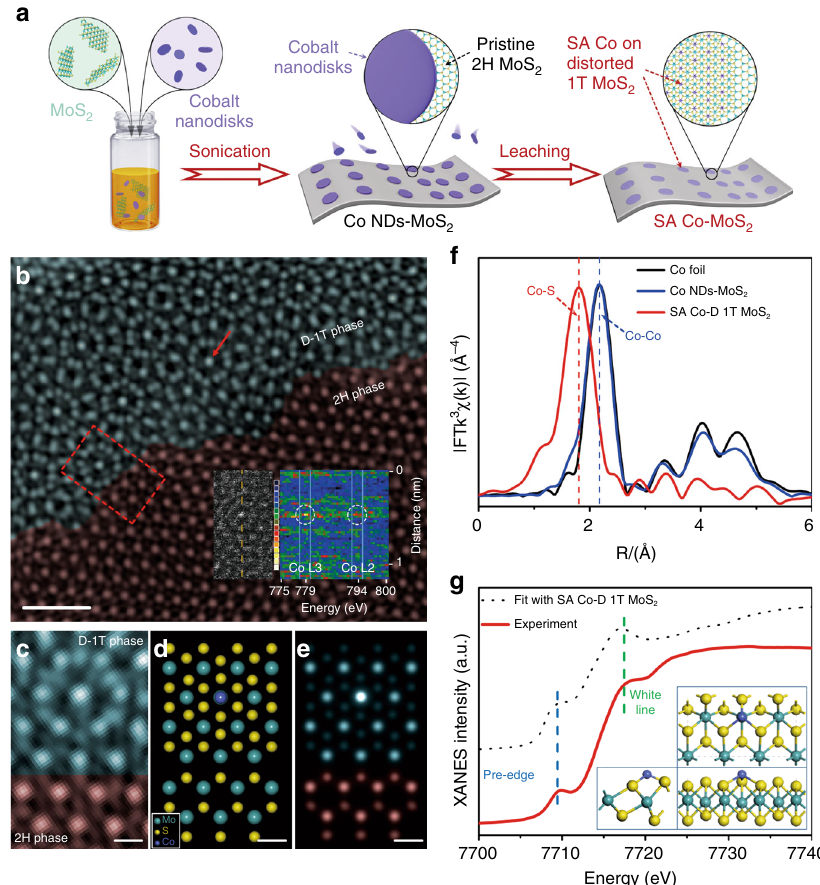
Fig. 1 Schematic illustration of synthetic method for SA Co-D 1T MoS 2 and its characterization. a Schematic diagram of the fabrication process for SA Co-D 1T MoS 2 . b Aberration-corrected HAADF-STEM image of SA Co-D 1T MoS 2 , showing the obvious junction between SA Co-D 1T MoS 2 (dark cyan) and pristine 2H MoS 2 (wine). The inset shows the HRTEM and EELS spectrum of SA Co-D 1T MoS 2 (scale bar: 1 nm). c Enlarged HAADF-STEM image in the red square area of b (scale bar: 2 Å). d Theoretical model and e simulated STEM images using QSTEM simulation software (scale bar: 2 Å). f FT-EXAFS spectra of SA Co-D 1T MoS 2 and bulk cobalt foil at the Co K-edge. g Co K-edge XANES of SA Co-D 1T MoS 2 and fi tted curve. The inset shows the